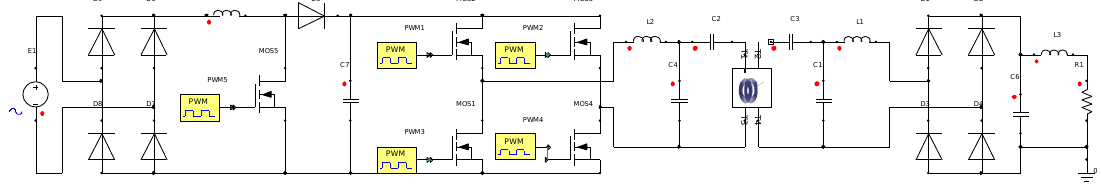
Figure 8. Circuit of the WCS.